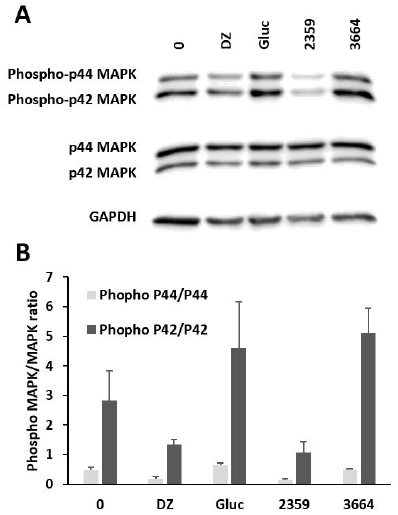
Figure 7. Manipulation of p44/42 phosphorylation. Western blotting ( A ) and quantitative analysis of each band ( B ) of whole-cell extracts from MIN6 β cells after treatment with the indicated substances for 1 h: Blank (0), 250 µM diazoxide (DZ), 10 mM glucose (Gluc), Filipendula ulmaria (2359, 10 µg/mL) and Lycium barbarum (3664, 10 µg/mL). Mean ± SEM ( n = 3).